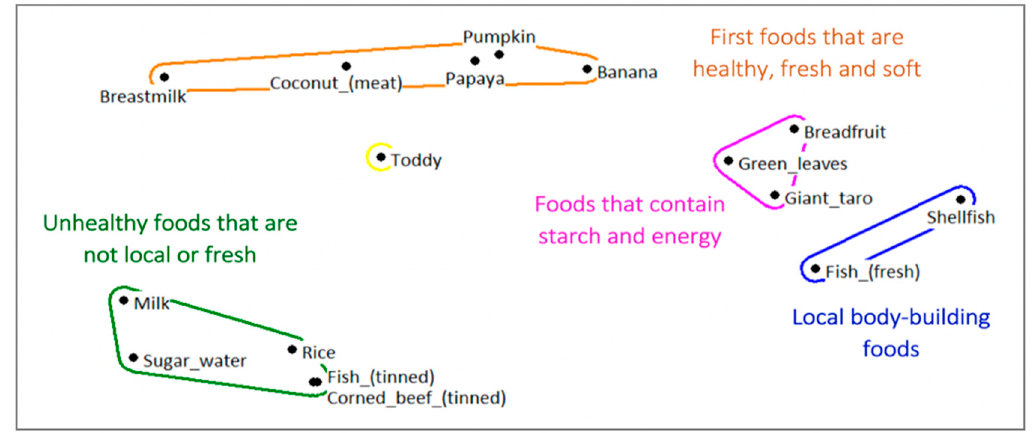
Figure 2. Multi-dimensional scaling map of pile sorting ‘young child foods’ in South Tarawa [urban].